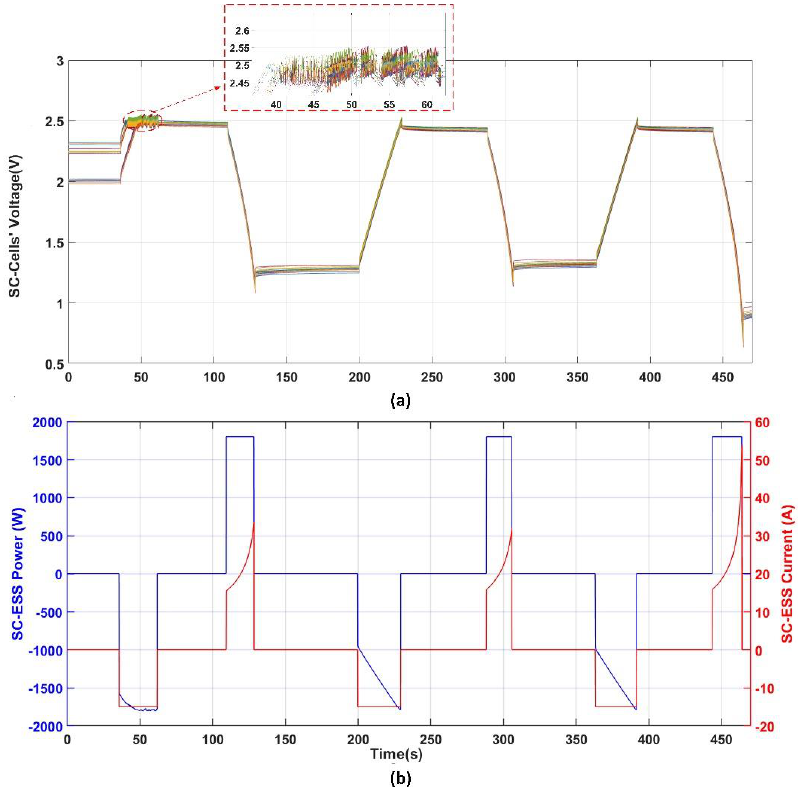
Figure 9. Performing of protective action to protect the SC cells by OVP subsystem during continuous charge/discharge cycling: ( a ) SC cells ’ voltages; ( b ) charge/discharge power and current.